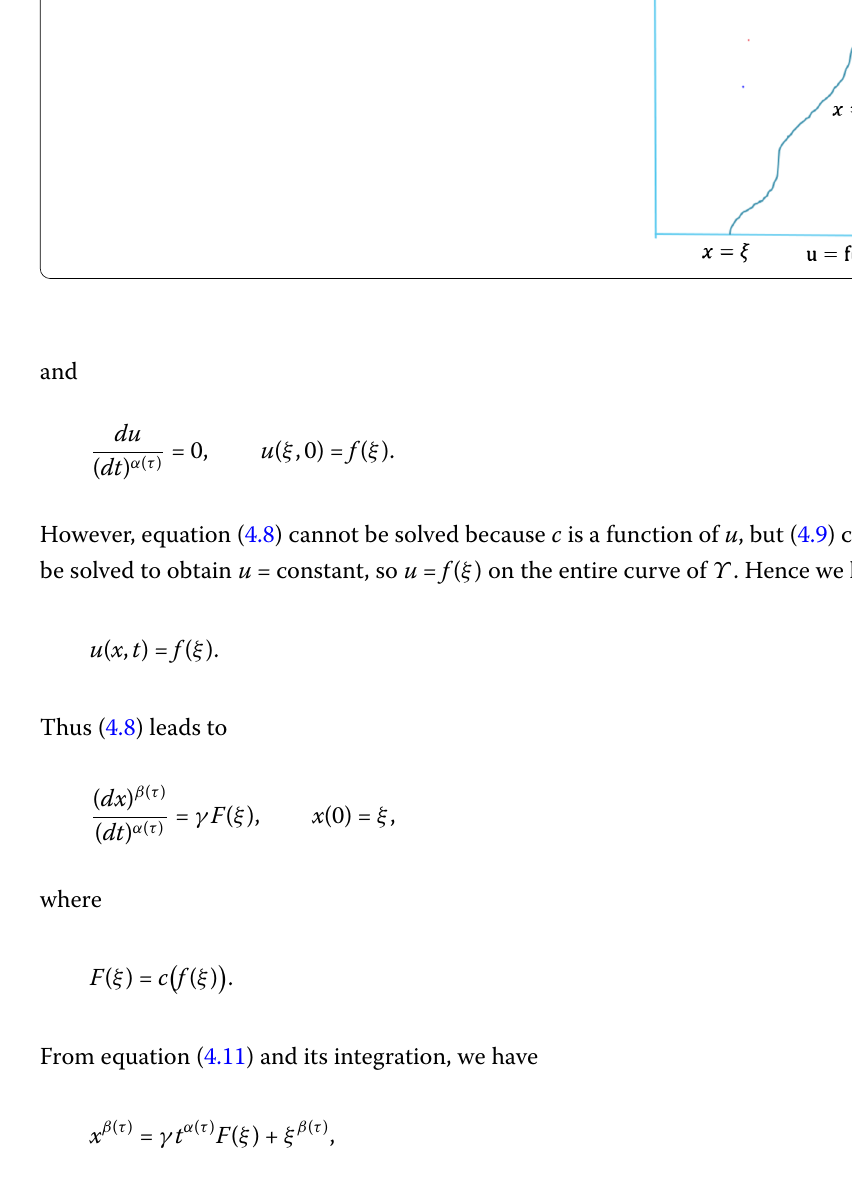
Figure 1 A characteristic